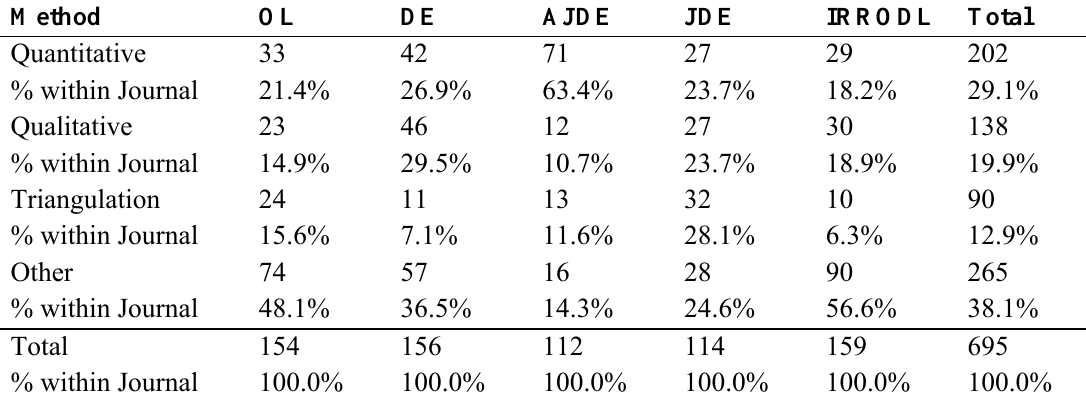
Cross Tabulation of Methods and Journals (N =